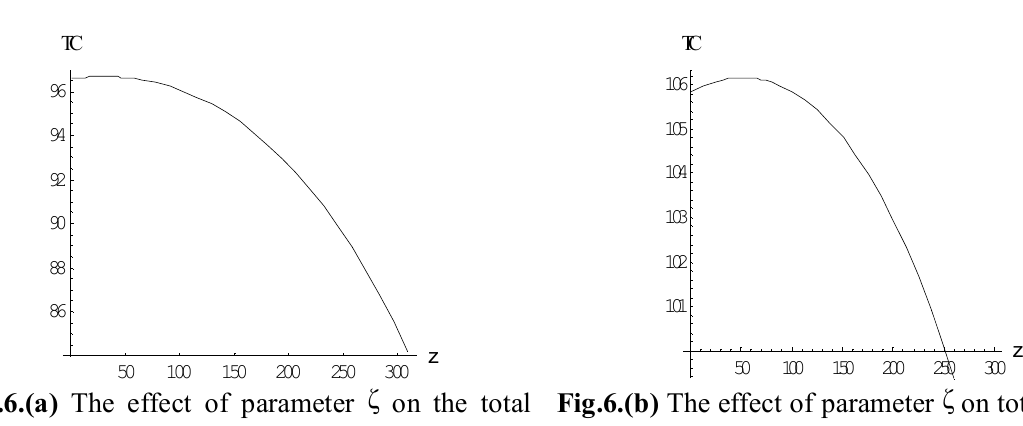
Fig. 5(b) The effect of parameter a on the total cost in the fuzzy model